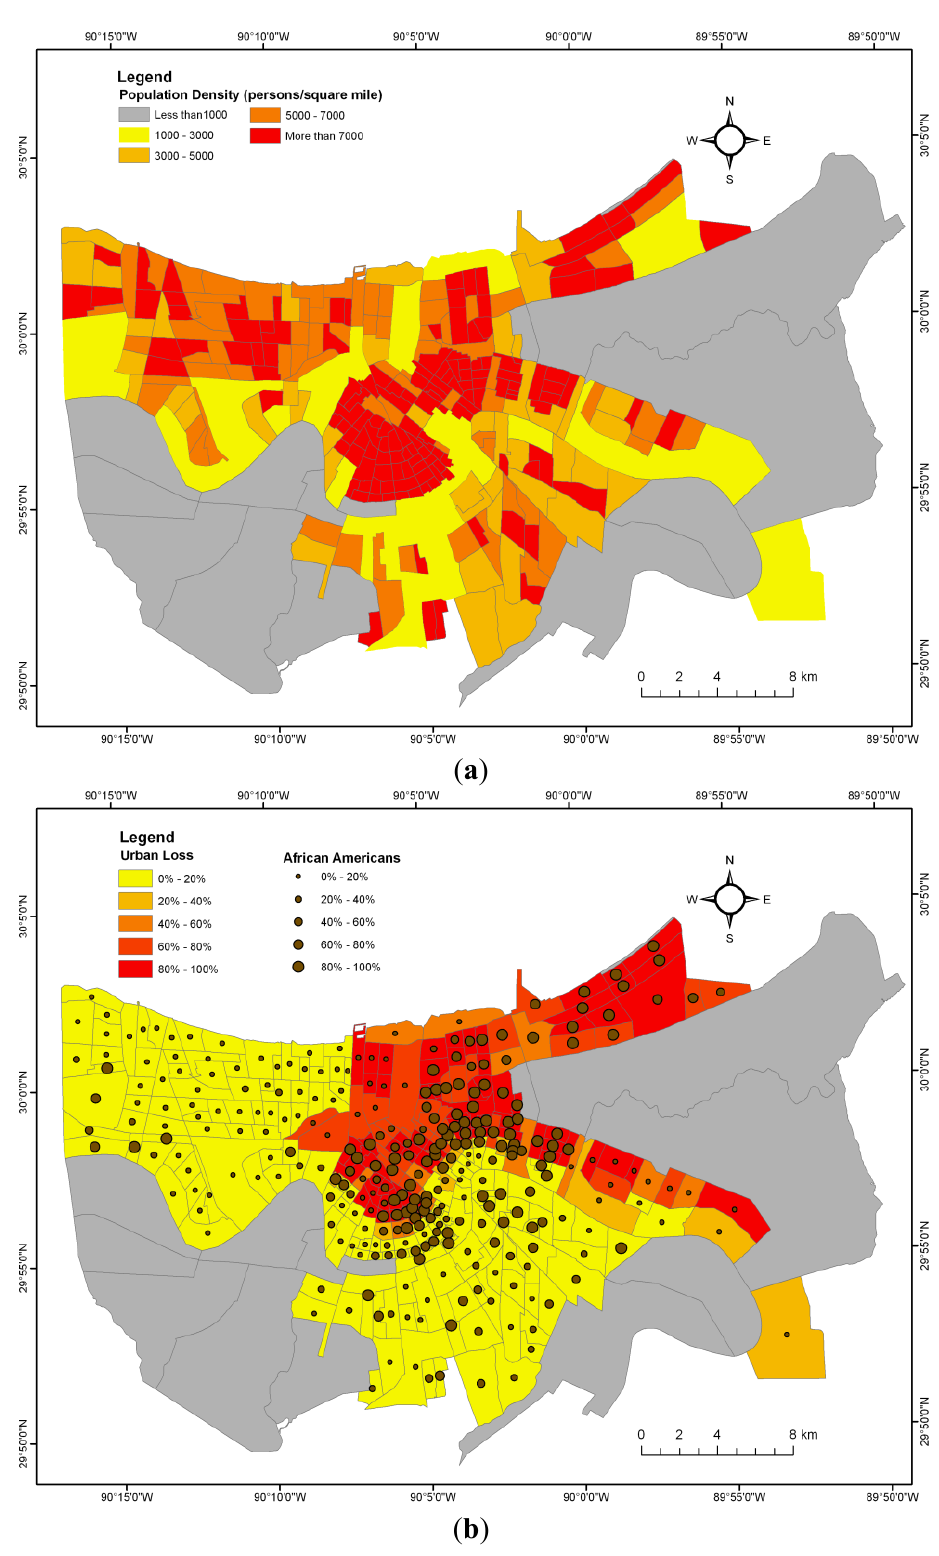
Figure 7. Population